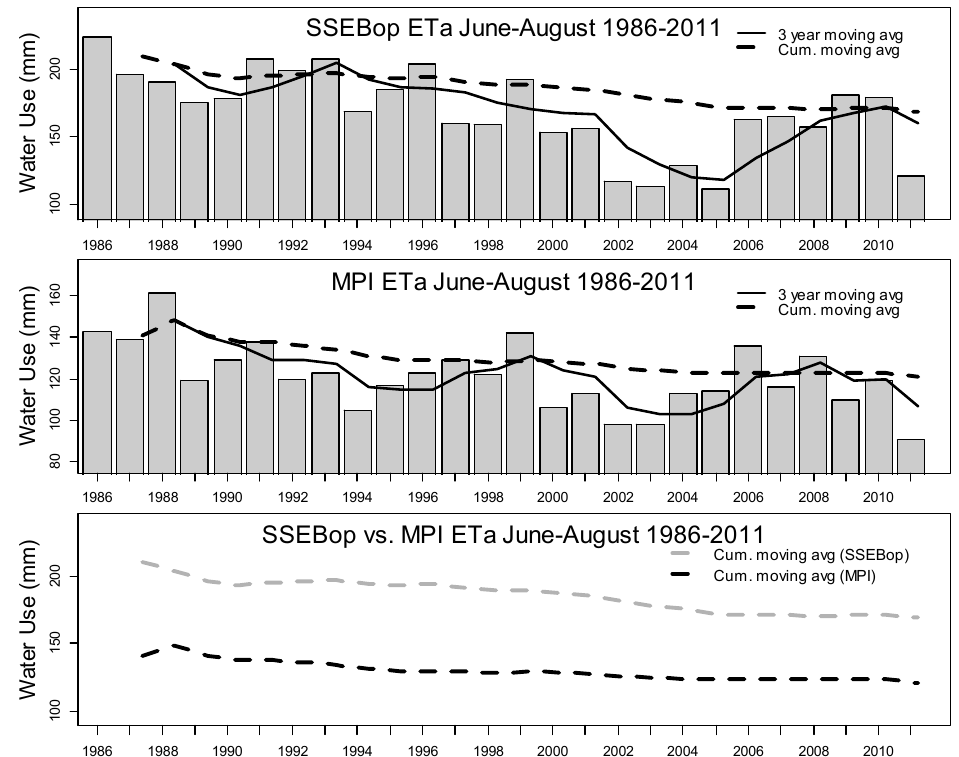
Figure 4. June–August ETa for 1986–2011 for all landcover types in the Upper Rio Grande Basin including the 3-year moving average and the cumulative average. The top chart shows the SSEBop basin averages; the middle chart shows the MPI basin averages; the bottom chart shows the cumulative moving averages for both MPI and SSEBop ETa.